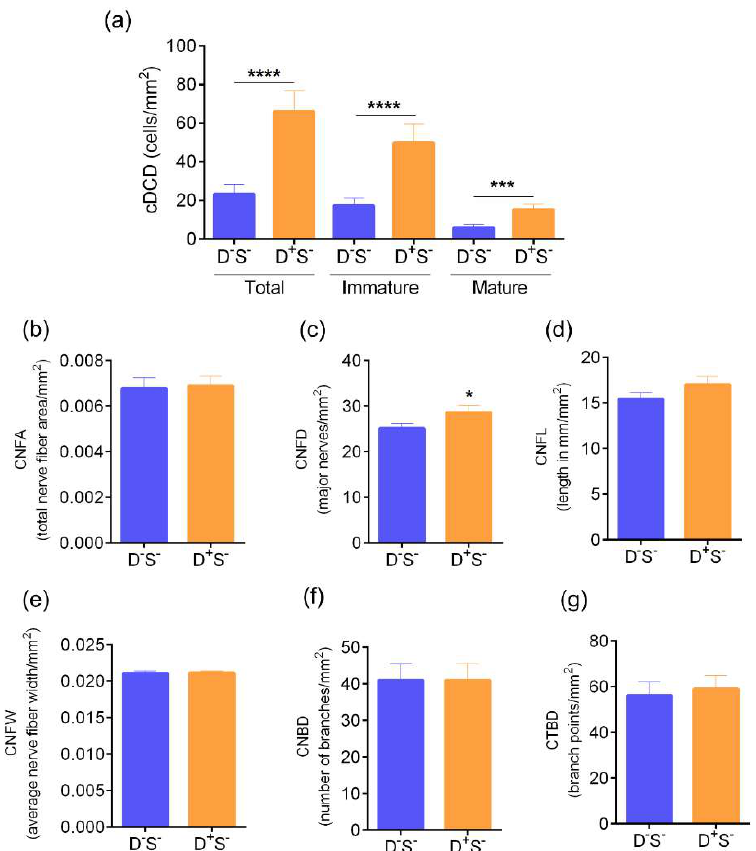
Figure 7. Ocular surface disease index score, Tear break up time, and Schirmer’s test values in subjects with discomfort but no signs. Bar graphs represent ( a ) Ocular surface disease index (OSDI) scores indicative of the discomfort/symptoms, ( b ) Tear break up time (TBUT) values in secs—indicative of sign and ( c ) Schirmer’s test (ST1) values in mm/5 min—indicative of sign in the study subjects. D - S - indicates subjects without discomfort/symptoms and signs (n = 58 eyes) and D + S - indicates subjects with discomfort/symptoms but no signs (n = 28 eyes). * p < 0.05, **** p < 0.0001, Mann–Whitney Test was performed. Age (D - S - , median (range) 32.5 (25–73) yrs and D + S - , 30 (20–57) yrs). Sex distribution (D - S - , M/F 16/14 and D + S - , M/F 4/10).